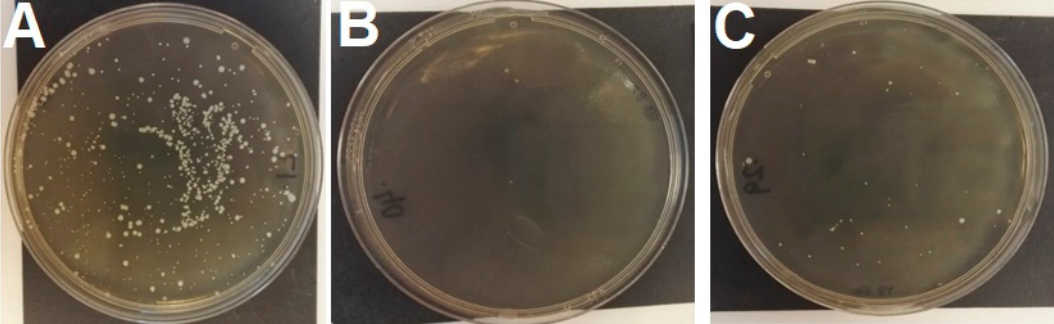
Figure 1. Recipient MSSP 287735 growth after transduction assays ( A ) on agar containing 30 mg/L tetracycline with phage lysate from MRSP 1726 ( tet(M) donor); ( B ) on agar containing 30 mg/L tetracycline control with no phage lysate; ( C ) on agar containing 16 mg/L fusidic acid with no phage lysate. Note the breakthrough growth on plate C (colony count n = 41). Smaller colonies are those embedded in the agar.